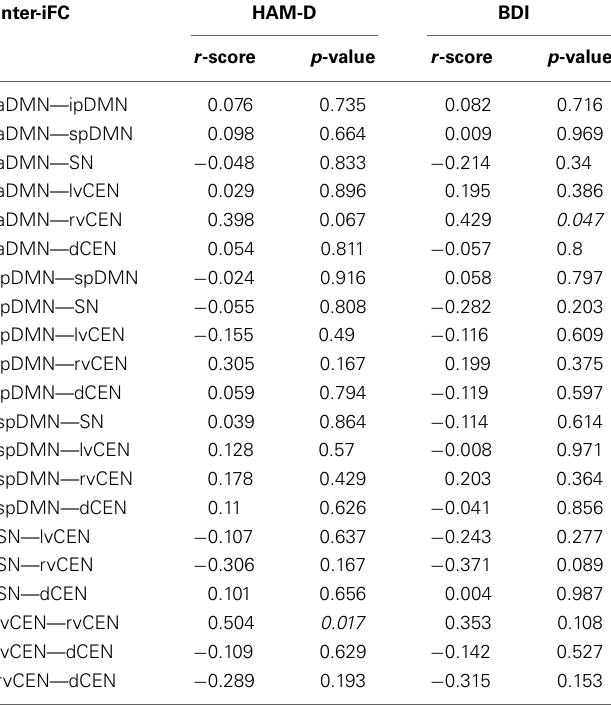
Table 7 | Partial correlations between inter-iFC and severity of symptoms in patients with major depressive